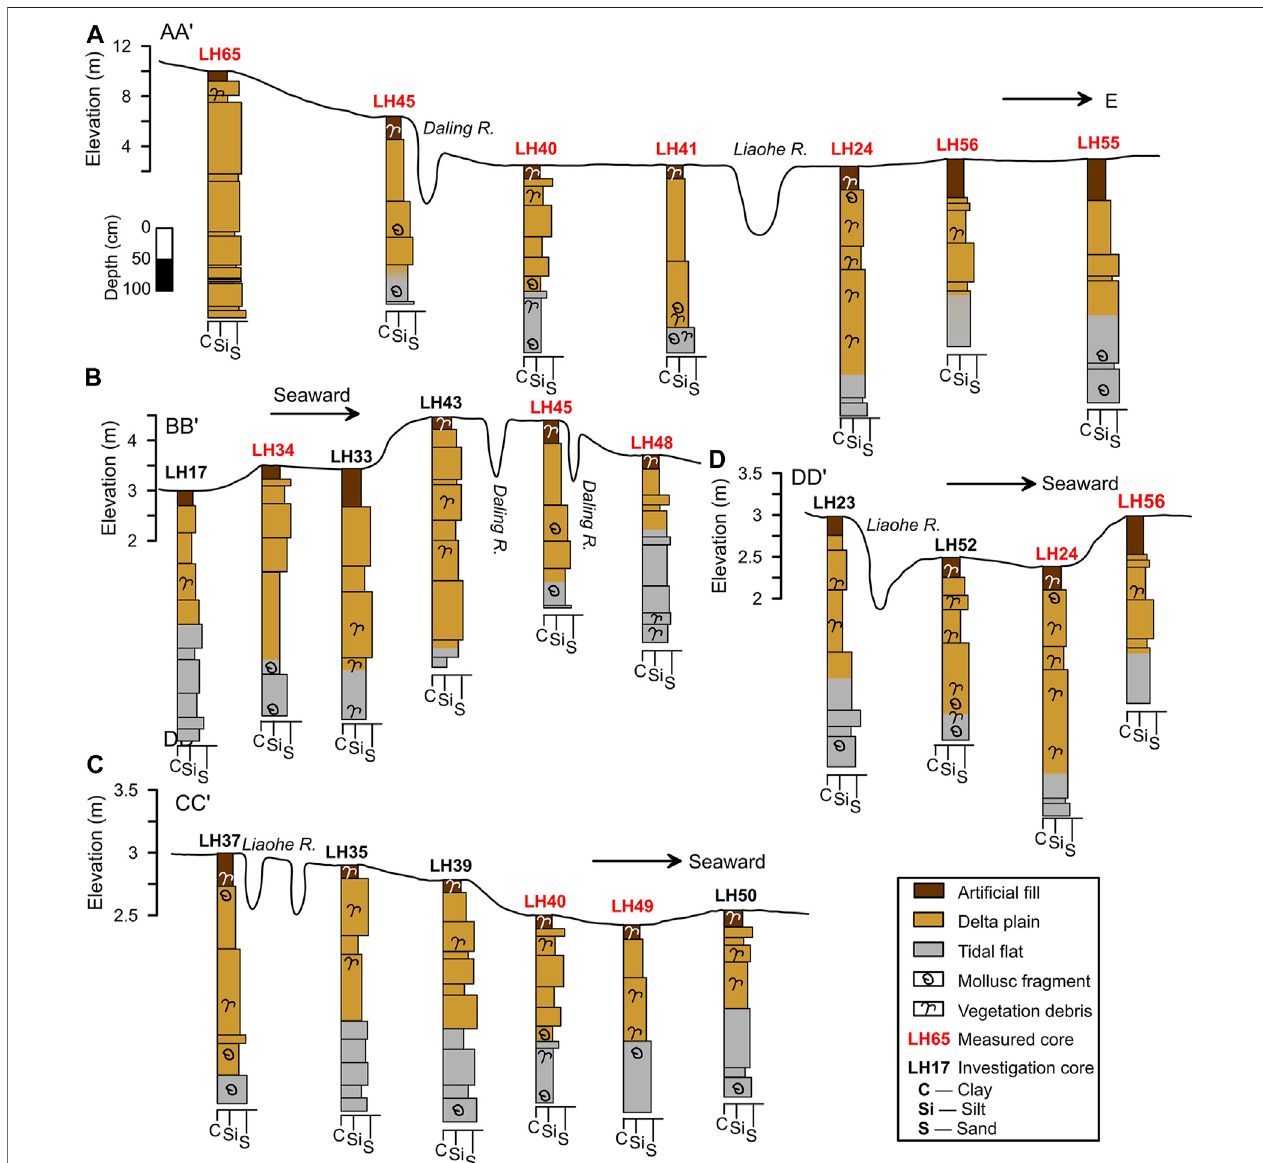
FIGURE 2 | Lithology of the core sediments from the four cross sections AA ′ , BB ′ , CC ′ , and DD ′ shown in Figure 1 .